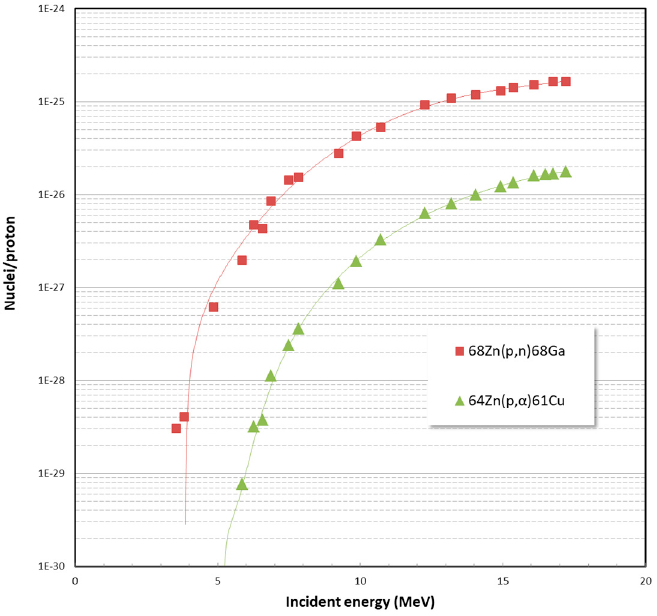
Figure 2. Experimentally measured thick target yields at saturation for the production of 61 Cu and 68 Ga from the proton irradiation of liquid targets containing dissolved natural zinc.